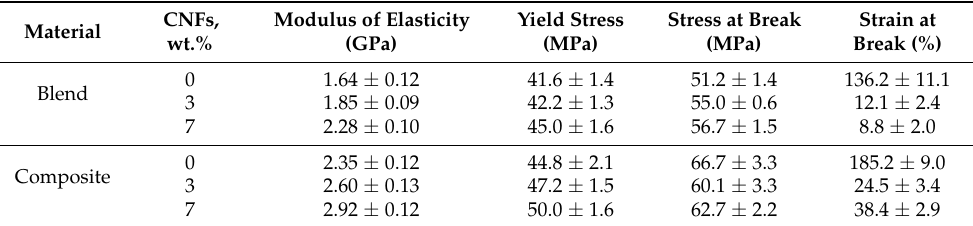
Table 1. Mechanical properties of PLA/PBAT/CNFs blends and